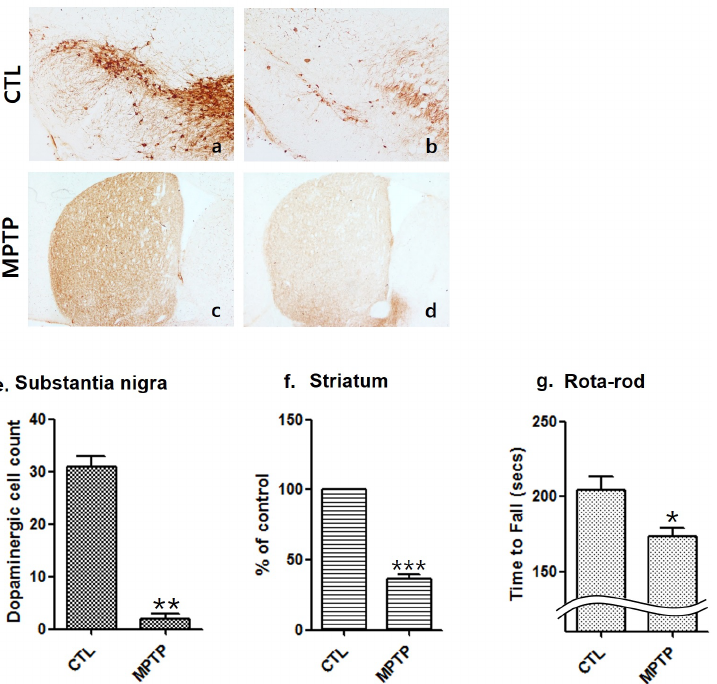
Figure 1. Reduction of dopaminergic cells and tyrosine hydroxylase expression in an MPTP-induced Parkinson’s disease mouse model. Immunohistochemically stained substantia nigra (SN, ( a , b )) and striatum (ST, ( c , d )) using a tyrosine hydroxylase (TH; ( a , b ), 100×; ( c , d ), 40×) antibody. ( e ) Decrease in dopaminergic cells in the SN in the MPTP group ( n = 3). ( f ) Immunostaining analyses of the TH level per area in the ST showing the decrease in TH expression in the MPTP groups ( n = 3). ( g ) The rotarod (28 mm diameter) test was conducted during 5 min of running time. First, the Accel Forward mode from 10 to 50 rpm was performed for 4 min and a constant speed of 50 rpm maintained in the final 1 min ( n = 6). CTL, control (phosphate-buffered saline); MPTP, 1-methyl-4-phenyl-1,2,3,6-tetrahydropyridine. (* p < 0.05, ** p < 0.01, and *** p < 0.0005 were compared to